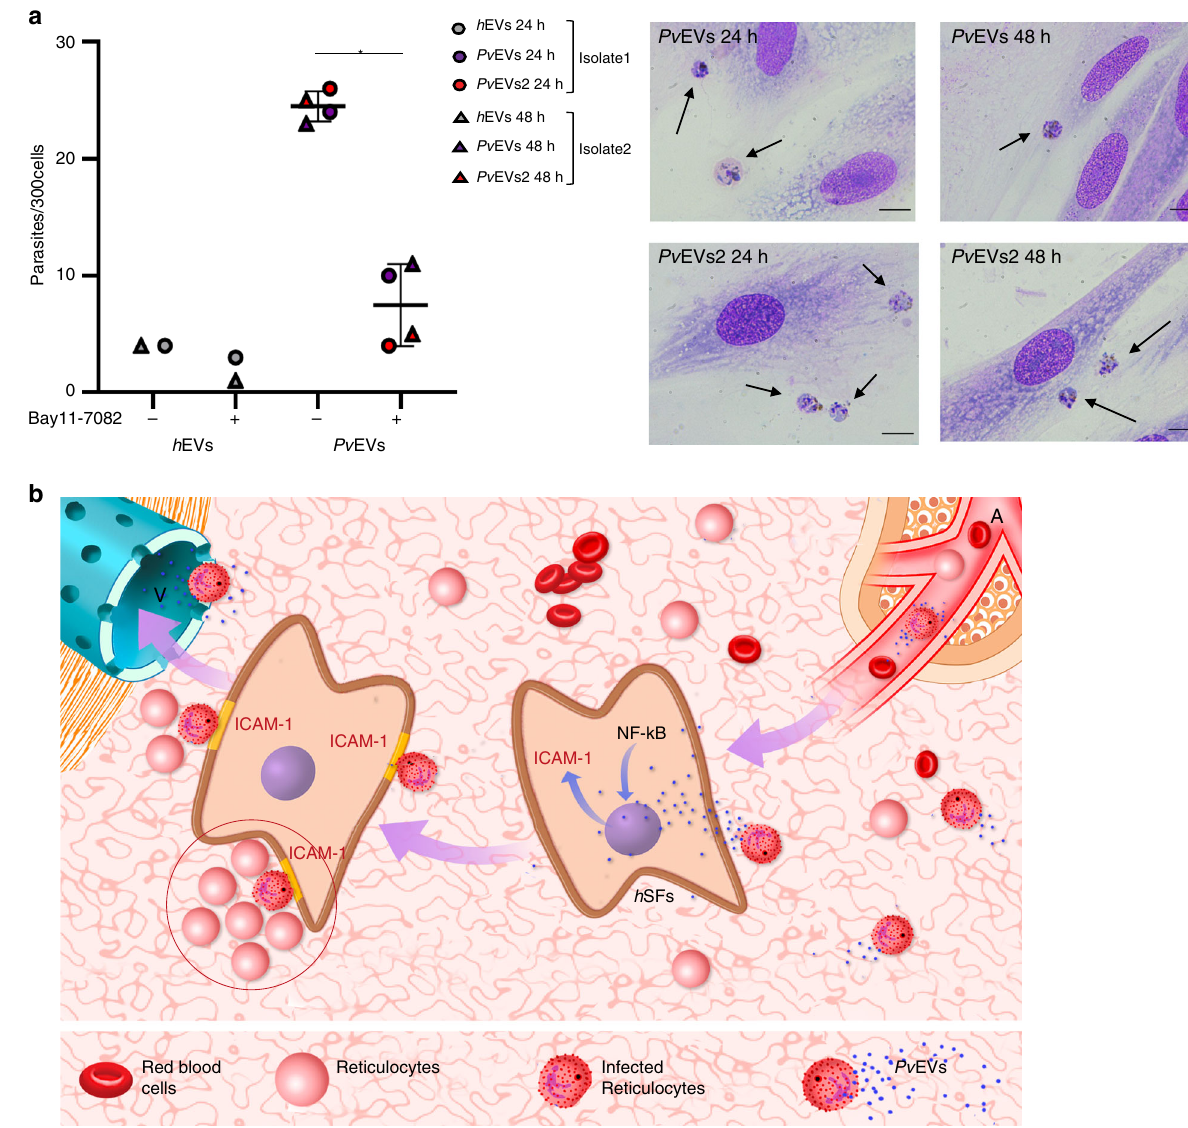
Fig. 4 Binding of P. vivax -infected reticulocytes to h SFs is NF-kB dependent. a Left panel: h SFs were cultured in the absence ( − ) or presence ( + ) of Bay11-7082 for 1 h and taken up experiments of pooled h EVs, Pv EVs or Pv EVs2 by h SFs made at 24 or 48 h, as indicated. Mature parasites from two different isolates (1 or 2) were added to pre-stimulated h SFs for 45 min. Bound parasites in 300 cells were counted twice for each condition by two different researchers. Data show mean ± SD ( n = 2 — h EVs and n = 4 — Pv EVs). Two-sided, Mann – Whitney test * p = 0.0286 (GraphPad). Source data are provided as a Source Data fi le. Right panel: phase contrast images of Giemsa-staining h SFs were captured by optical microscopy (×100/1.25 oil). Arrows show P. vivax parasites. Scale bars: 10 µ m. Each image represents each independent experiment as indicated. b Spleen model of the physiological role of EVs in P. vivax . Circulating plasma-derived extracellular vesicles from infected cells ( Pv EVs) enter the microvasculature of the spleen and are uptake by human spleen fi broblasts ( h SFs). This event signals NF-kB for translocation to the nucleus and transcription of ICAM-1. After translation of ICAM-1 and expression at the surface of h SFs, infected reticulocytes bind to these cells in a niche rich in reticulocytes (circled) where parasites can invade and multiply. A, arteriole; V,